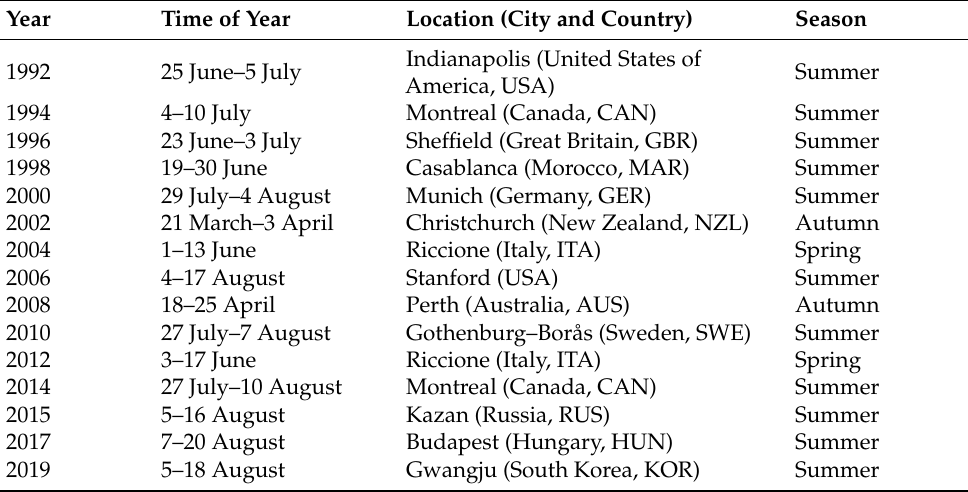
Table 1. Location of the FINA World Master Championships